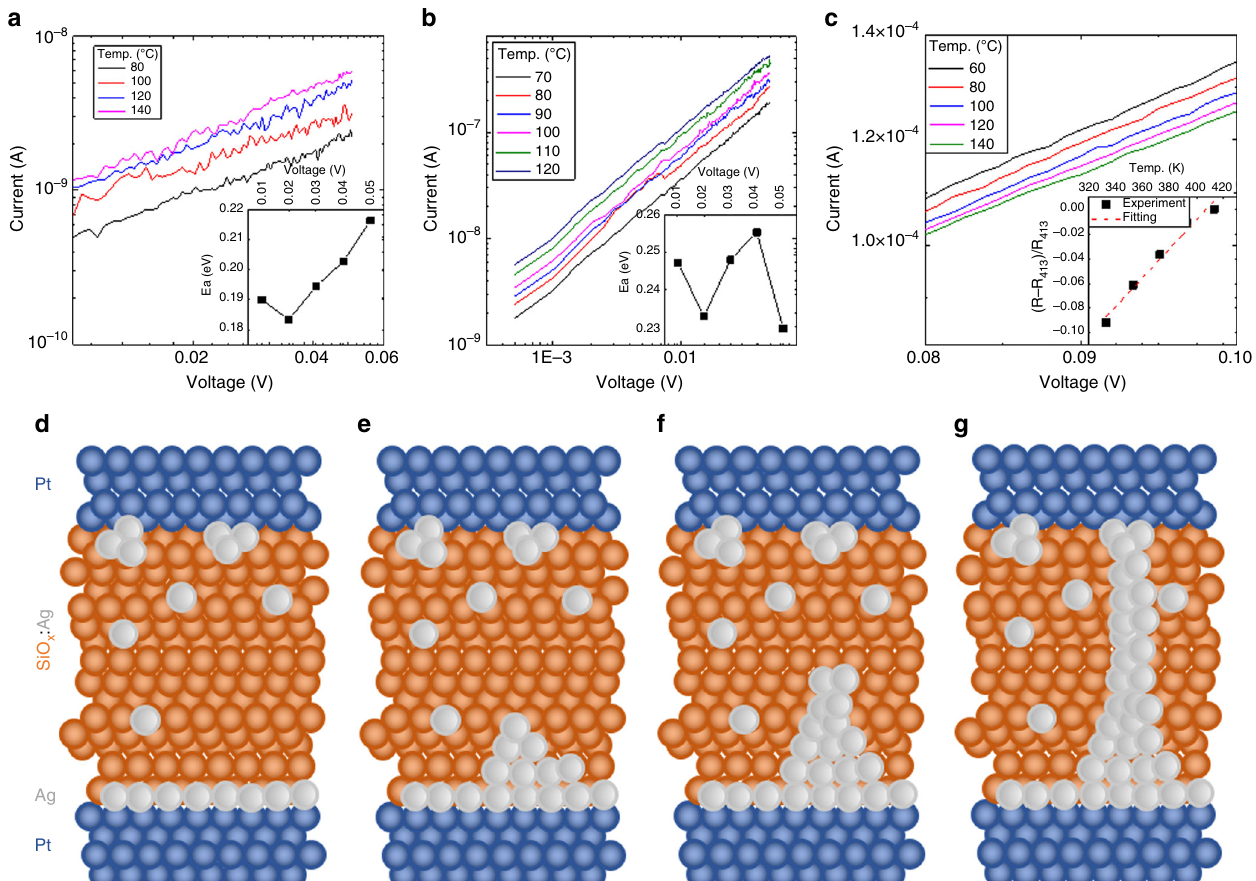
Fig. 5 Mechanism study for the change of the threshold properties. Log I – Log V curves measured at different temperatures of the partially electroformed state obtained by applying ( a ) 2 V (80 ~ 140 °C), ( b ) 3 V (70 ~ 120 °C) pre-pulses and (inset to a and b ). Extracted activation energy for hopping conduction between 0.01 V and 0.05 V ranges. ( c ) Temperature dependent I – V curves for fully electroformed state obtained by applying 4.5 V pre-pulse and (inset to c ) ( R – R 413K )/ R 413K vs. temperature plot. Schematic diagrams illustrating the distribution of Ag ions in ( d ) the normal off state, ( e and f ) partially electroformed state (2, 3 V), and ( g ) fully electroformed state (4.5